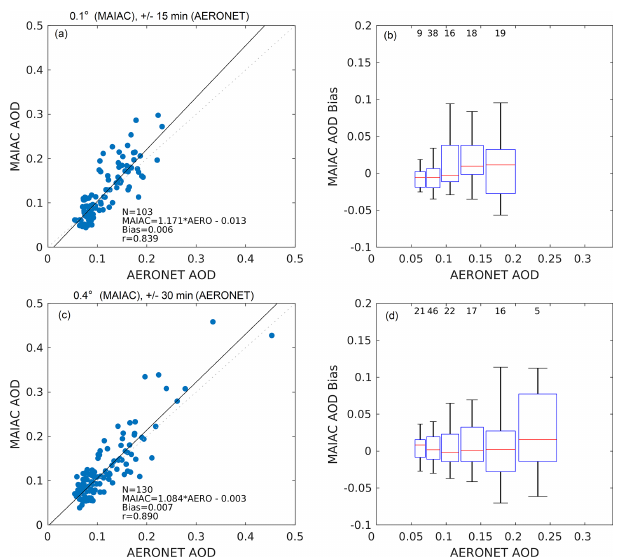
Figure 5. Scatterplots (a, c) of the relationship between AERONET AOD and MAIAC during 3–8 August 2019. Results are shown for two sets of data collocation methods. The dotted line represents the 1 : 1 line, and the solid line represents the linear regression model provided in the figure. The box-and-whisker plots (b, d) show the dependence of MAIAC biases compared against AERONET. Miss- ing boxes are due to the lack of matchups ( < 5) in that AOD bin. The edges of boxes and the red line represent 25th and 75th percentiles and the median. The whiskers represent 5th and 95th percentiles. The numbers at the top of (b) and (d) are the numbers of matchups in each bin of AERONET